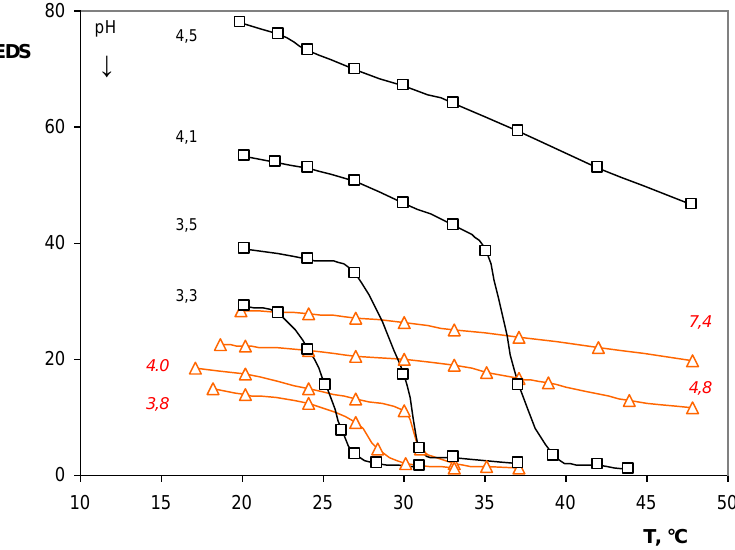
Figure 6. Equilibrium degree of swelling (EDS) in relation to the temperature for the hydrogels NIP-AVa-PEG575 (dark squares) and NIP-AVa-PEG258 (red triangles) in acetate and PBS buffers in 0,15 M